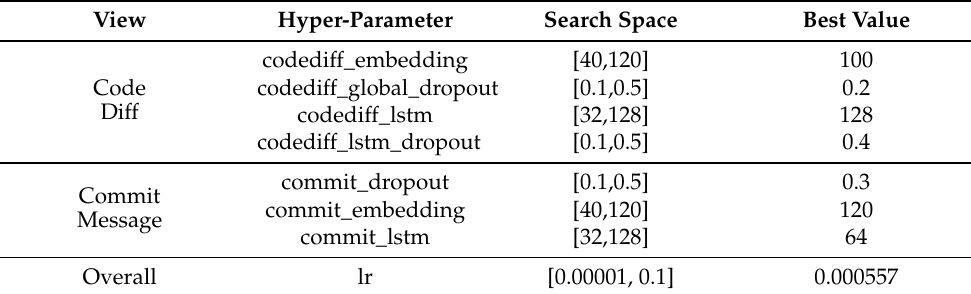
Table 2. The hyperparameters tuning details.